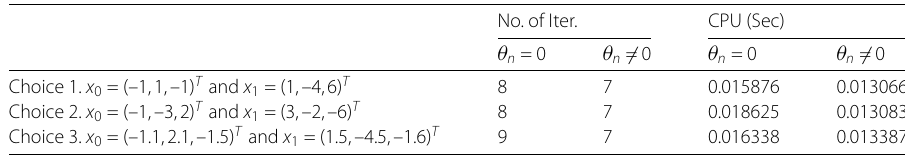
Table 1 Numerical results for Example 5.1